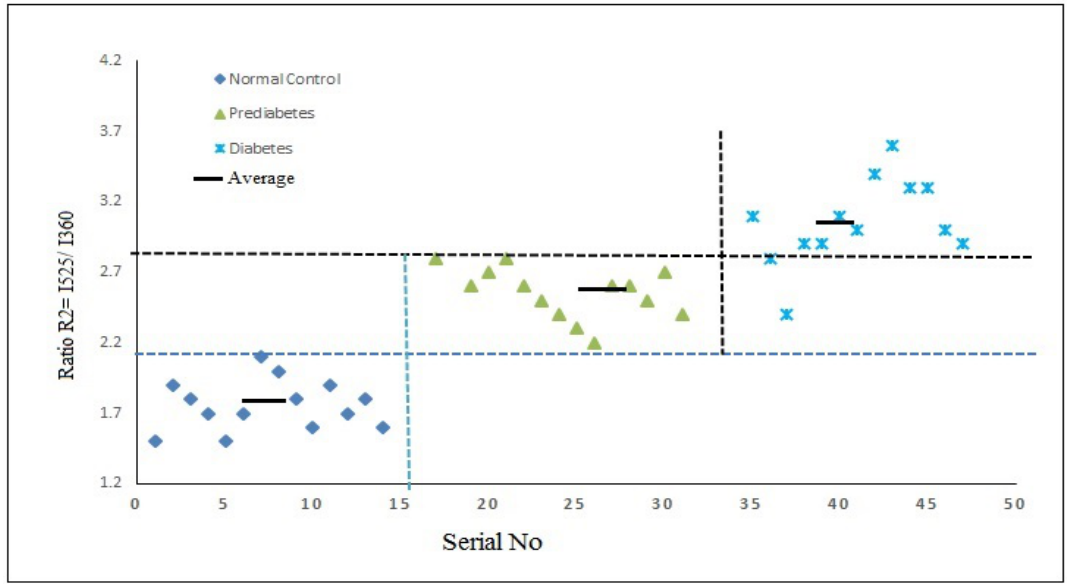
Figure 7. Scatter plot of R 2 = I 525 /I 360 values of the above three subjects. R 2 is a measure of the redox reaction and decay rate of any cell—in this case, RBCs (red blood cells).